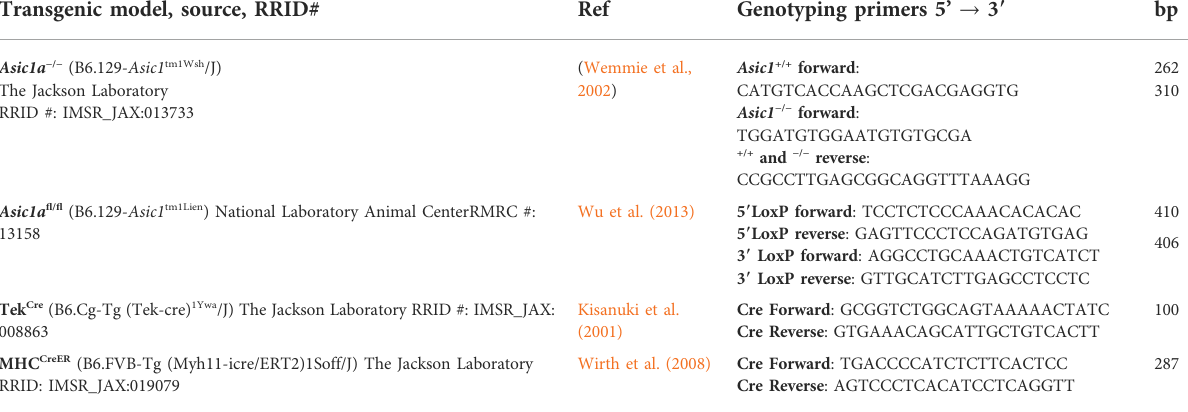
TABLE 1 Transgenic mouse models, source, reference, primers, and expected base pairs to identify each genotype. Transgenic model, source,